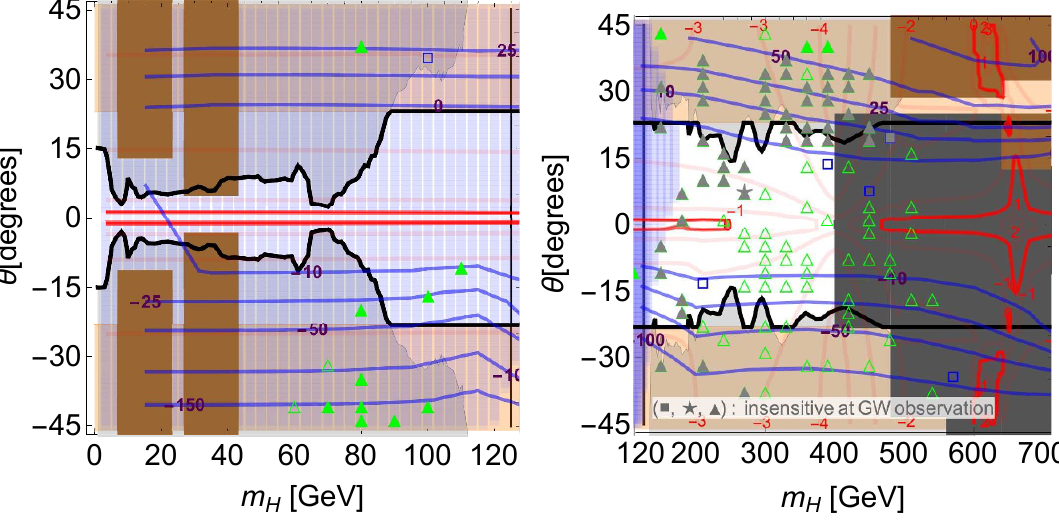
Figure 3 . Types of multi-step PT on the ( m H , θ ) plane for the benchmark point m X = 200 GeV and g X = 2 ( v S = 100 GeV). The left (right) frame shows light heavy H cases: m H < m h (heavy H cases: m H > m h ). Parameter sets predicting one-step PT with 1st order are marked with blue closed square, one-step PT with 2nd order with blue open square, two-step PT where both transitions are 1st order with green closed star, two-step PT where the latter one is 1st order with green closed triangle, and two-step PT where the former one is 1st order with green open triangle. The blue solid lines show the contours of ∆ λ hhh in percentage. The black lines show the combined exclusion limit obtained by κ Z measurement (orange) and direct searches for H (gray). In Model B, the following constraints on DM properties should be imposed. The red lines show the contours of the normalized relic density Ω X / Ω in common logarithm (The red bold lines show the cases obs of Ω X = Ω ). The cyan regions are excluded by DM direct detection by XENON1T in terms of obs log 10 ( σ X Ω X / Ω ). For more details, see table obs ×